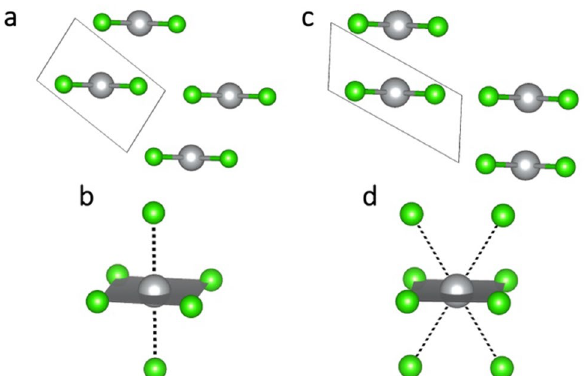
Figure 4. Structural changes in CuCl 2 -polymorph. (a,c) View along the direction of chain propagation at 10 and 20 GPa, respectively. (b,d) View of local coordination of Ag at 10 and 20 GPa, respectively. Ag—grey, Cl—